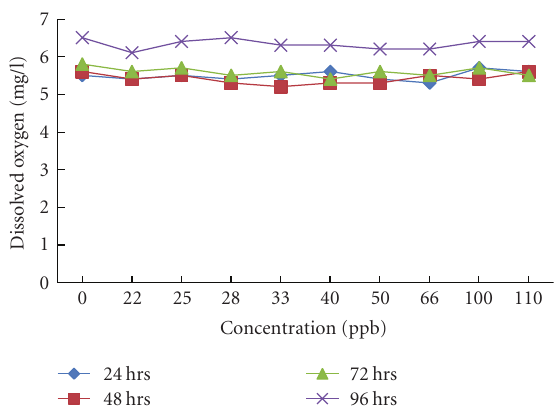
Figure 1: Dissolved oxygen of test solution during 96-hour expo- sure of Clarias gariepinus of various concentrations of gammalin 20.